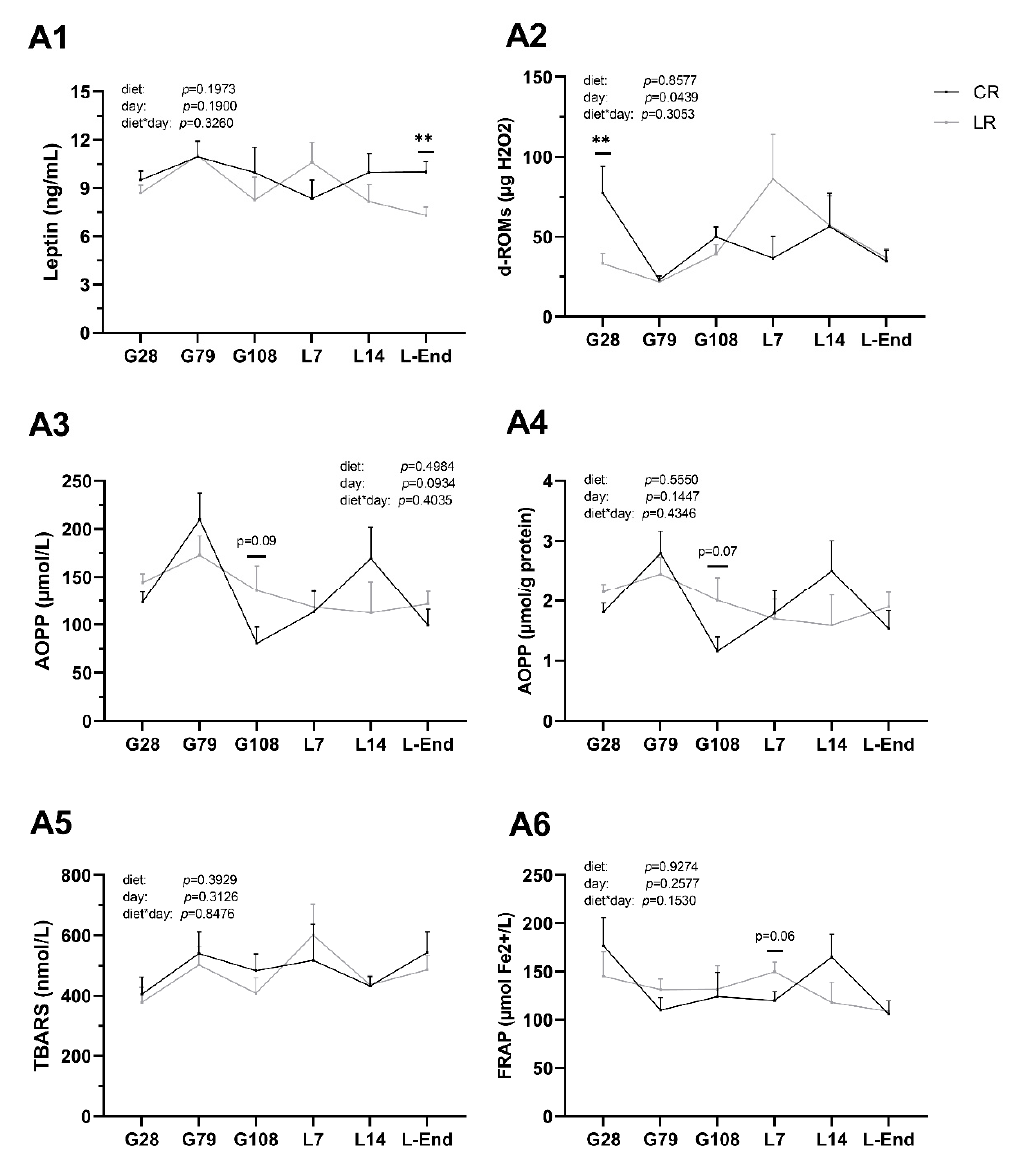
Figure 3. Concentrations of leptin and oxidative stress indicators of sow plasma during gestation and lactation periods. A1 : Leptin; A2 : The derivatives of reactive oxygen metabolites (d-ROMs); A3 , A4 : Advanced oxidation products of proteins (AOPP); A5 : Thiobarbituric acid reactive substances (TBARS); A6 : Ferric reducing ability of plasma (FRAP). CR: sow diet with ω 6: ω 3 ratio = 13:1 during gestation, starting from day 28 (G28) and 10:1 during lactation; LR: sow diet with ω 6: ω 3 ratio = 4:1 from G28 until L-End. G: days of gestation, L: days of lactation. Data are LSM ± SE; n = 6–8 sows per group. ** p < 0.01.